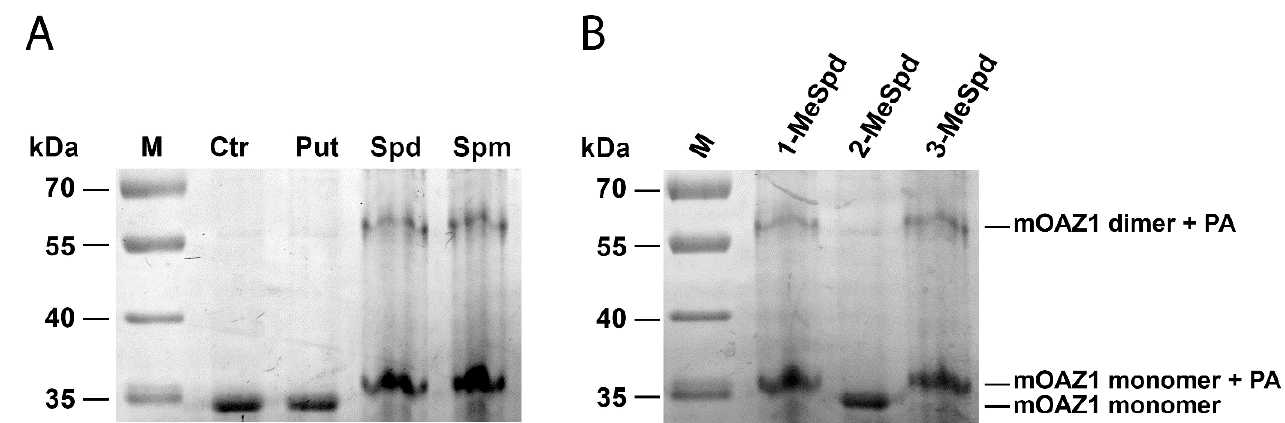
Figure 1. Formation of (mOAZ1) 2 -polyamine (PA) complex. ( A ) Spd and Spm induce dimerization of OAZ1. The recombinant mOAZ1 protein (1 μg/band) was incubated in the presence of 200 μM of polyamines for 30 min at 20 ◦ C at pH 7.5, and the reaction mixtures were resolved on a 12% poly- acrylamide gel (without SDS) in the presence of 0.01% SDS in the running buffer with a subsequent staining with Coomassie Blue R-250. ( B ) 1-MeSpd and 3-MeSpd, but not 2-MeSpd, bind to mOAZ1 and induce its dimerization. The conditions of the complex formation and electrophoresis are the same as in Figure 1A.